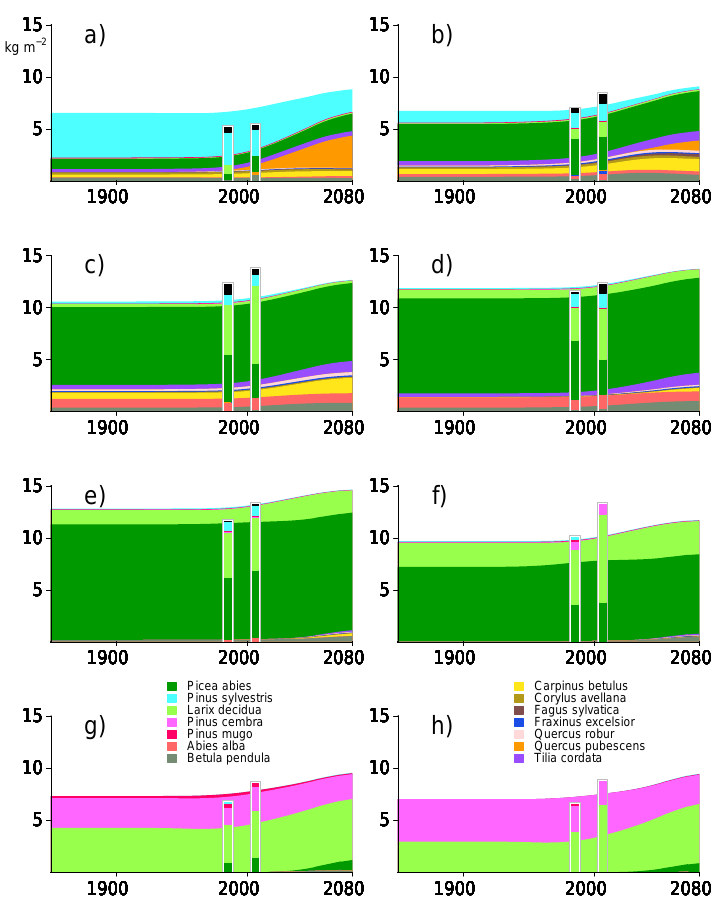
Fig. D4. Single-species carbon mass with LPJ-GUESS applying the GAPPARD method. See Fig. D3 for descriptions.